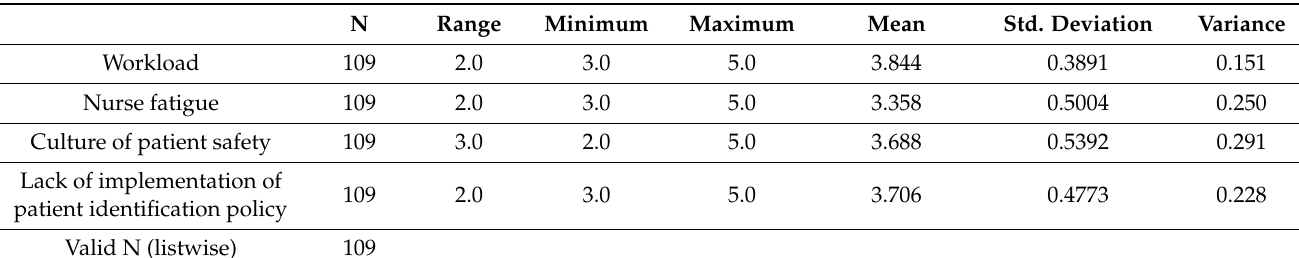
Table 6. Descriptive analysis for other factors.